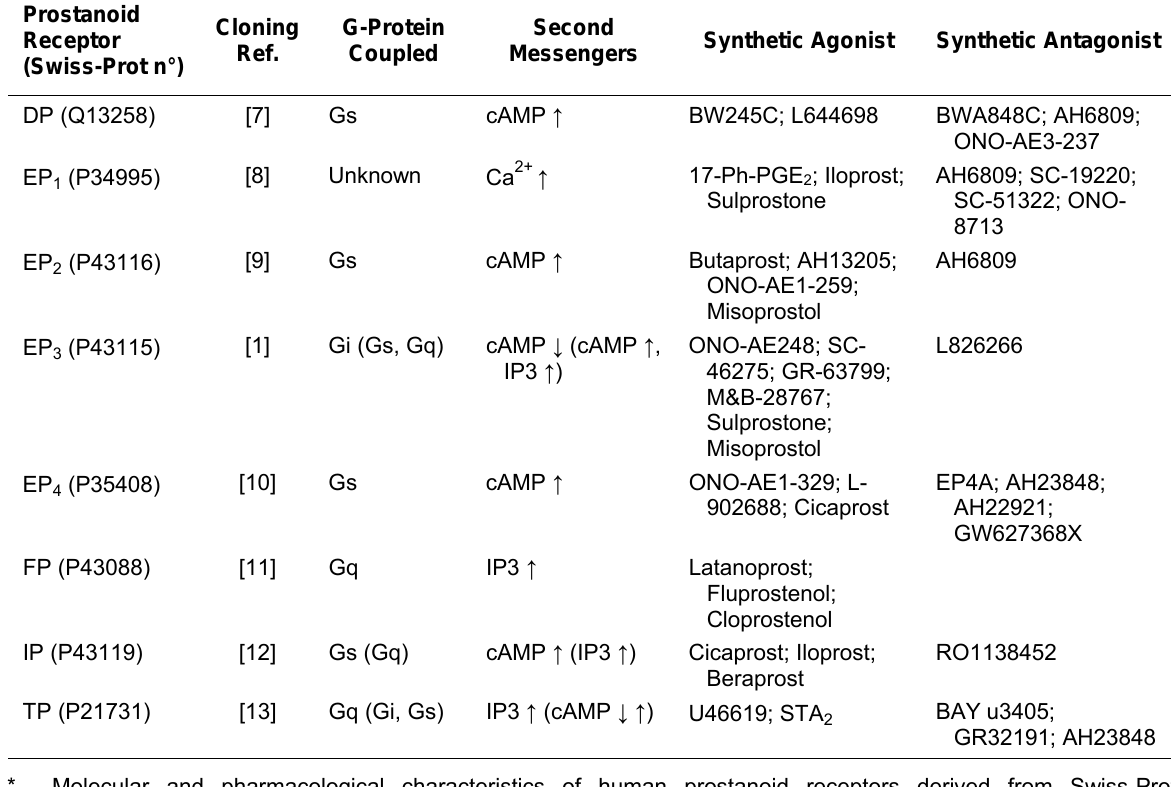
Types and Subtypes of Classical Prostanoid